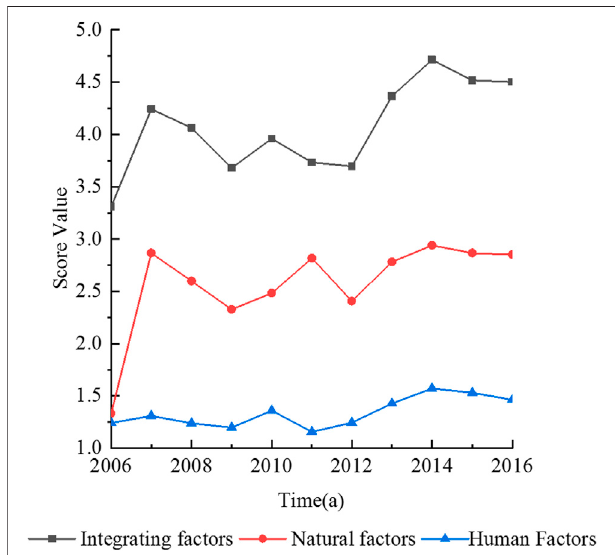
FIGURE 8 | Evolution of the principal component scores with time affected by various factors.